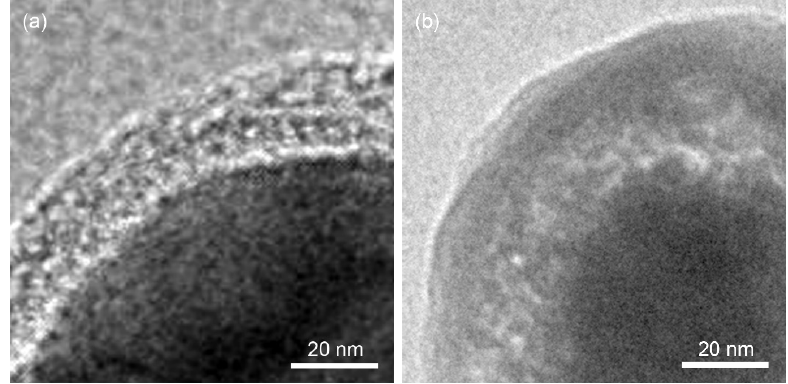
Figure 4. TEM images of PDA@TiC − 60 ( a ) and PDA@TiC − 20 ( b ).